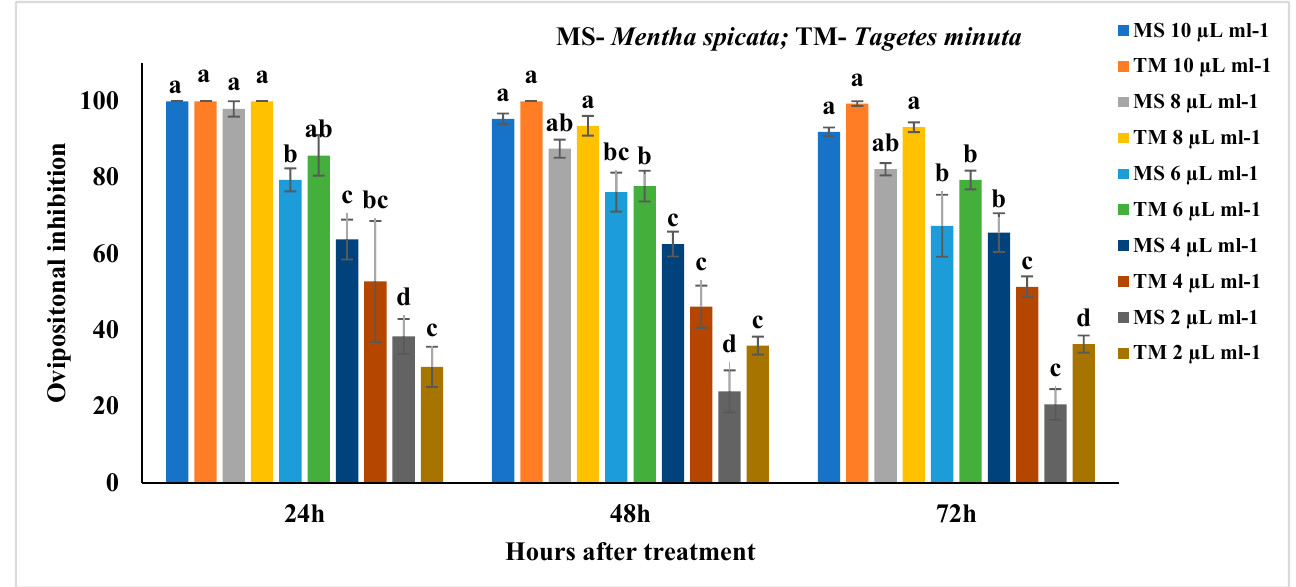
Figure 3. Ovipositional inhibition of Mentha spicata and Tagetes minuta against Callosobruchus chinensis ; Means followed by the same letter within the error bars are not statistically different by Tukey ( p ≤ 0.05).